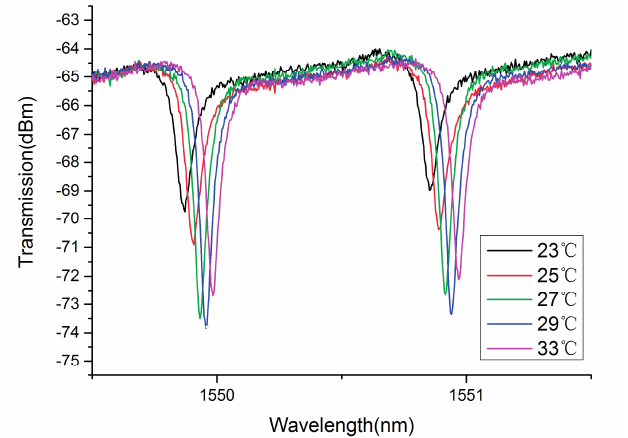
Figure 5. The resonant spectra at different temperatures with 2.45- μ m-diameter